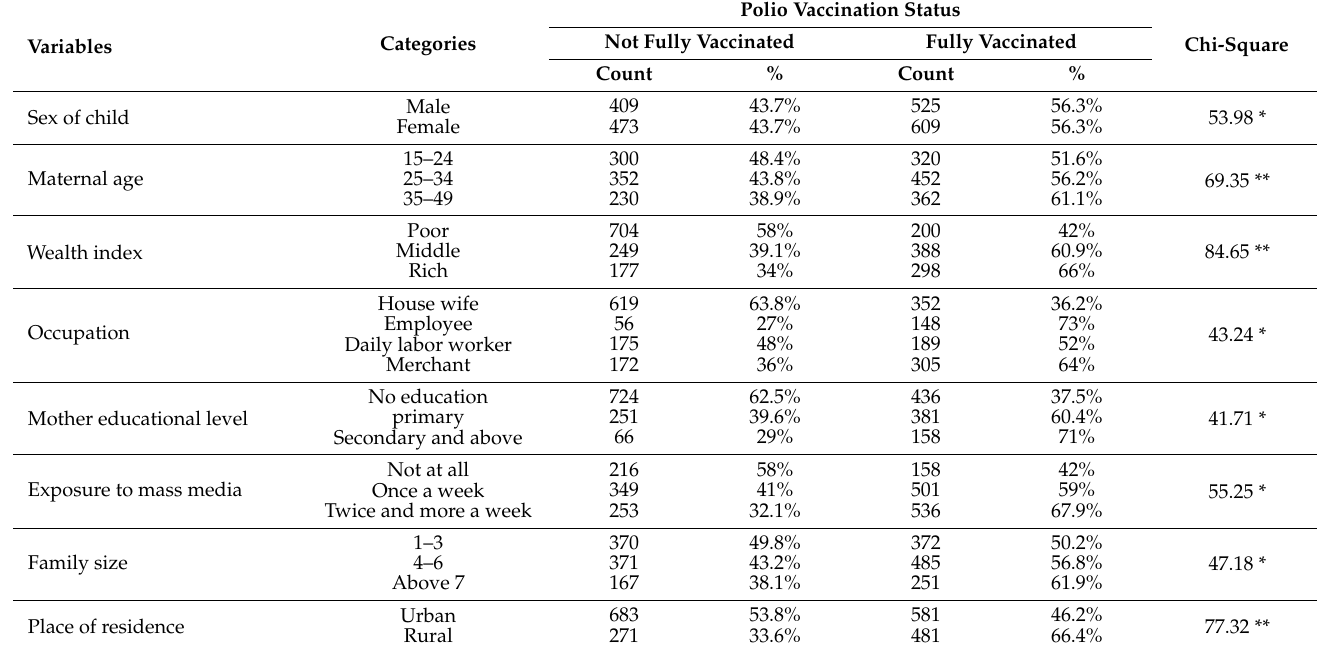
Table 1. Descriptive and test of association results on polio non-vaccination status with predictor variables.